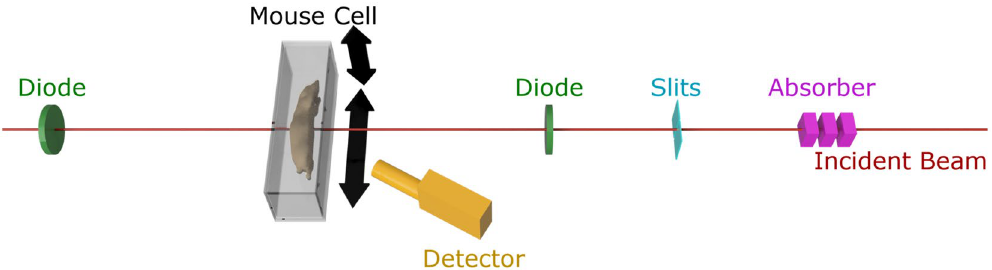
Figure 4. Schematic of the experimental setup. The beam (red) is attenuated by variable absorbers (pink) and collimated using slits (cyan). Its intensity is monitored before and after the interaction region using PIN diodes (green). The SDD (orange) is placed at 150 degree scattering angle in the polarization plane. To minimize attenuation to and from the thyroid, the mouse is lying on the